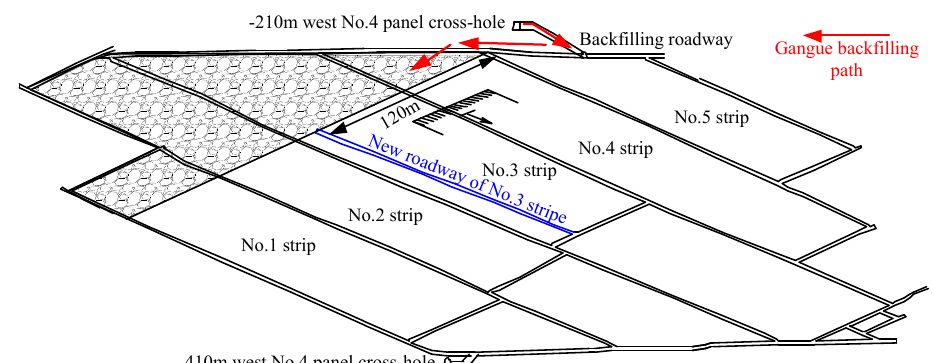
Figure 14. The 845 working face layout after optimization.